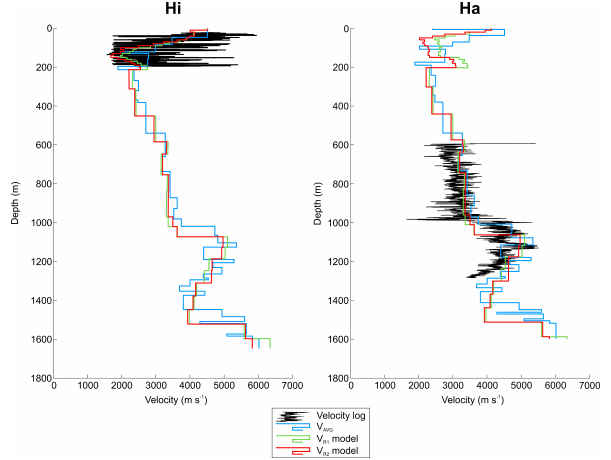
Figure 8. Velocity log data (in black) and 1-D velocity models pro- vided by the V R1 (in green) and V R2 (in red) models for the Hi and the Ha wells together with the predicted sonic logs of these two wells published in Alcalde et al. (2014; V AVG models, in